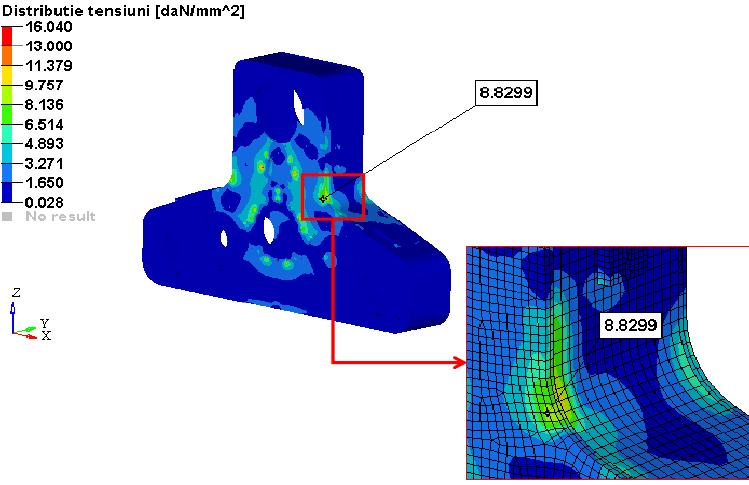
Figure 5. Stress field on the housing of the adder gearbox.